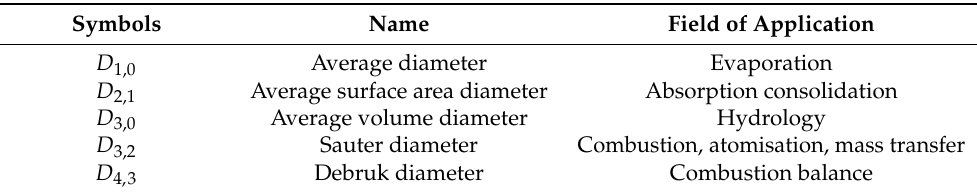
Table 2. The definition of the mean diameter.